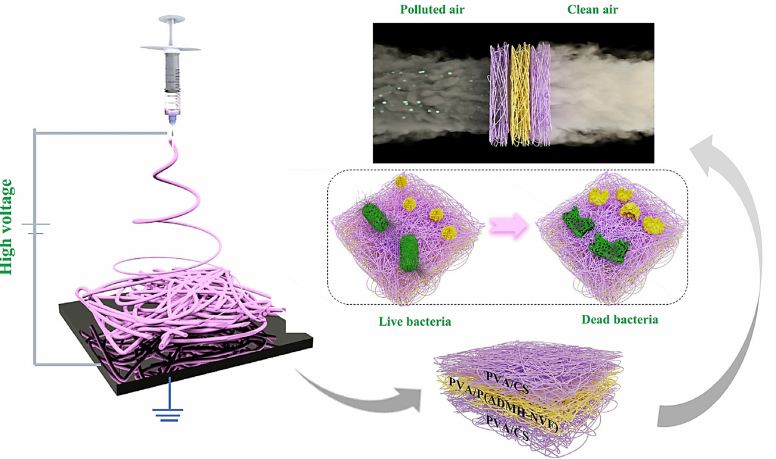
Figure 12. Electrospinning process used to fabricate multilayer air filters. Reprinted with permission from [32]. Copyright 2020 with permission from